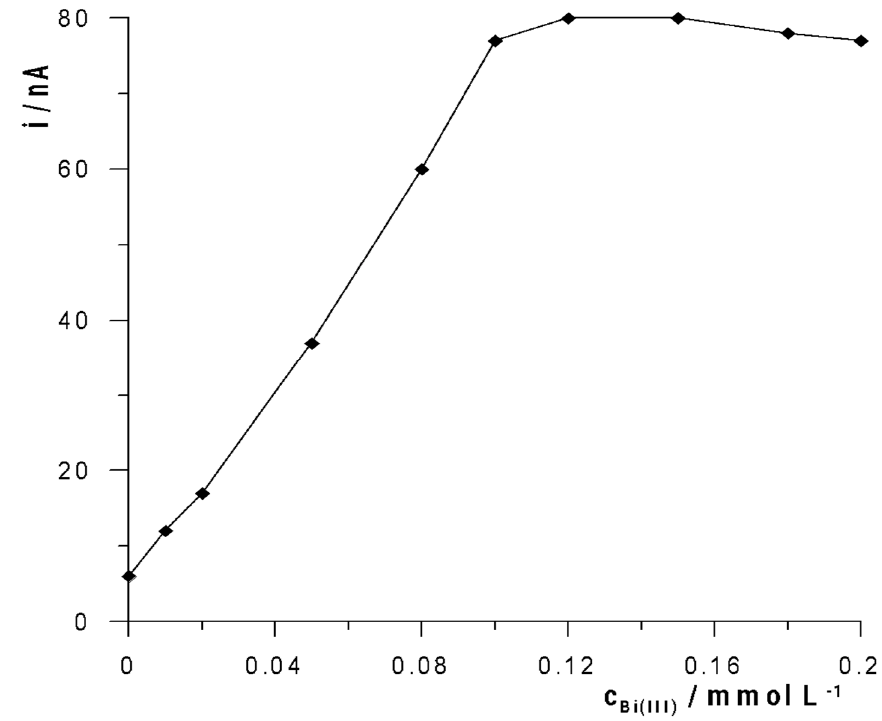
Figure 3. The influence of Bi(III) concentration on the 2 × 10 − 7 mol L − 1 Ga(III) peak current.